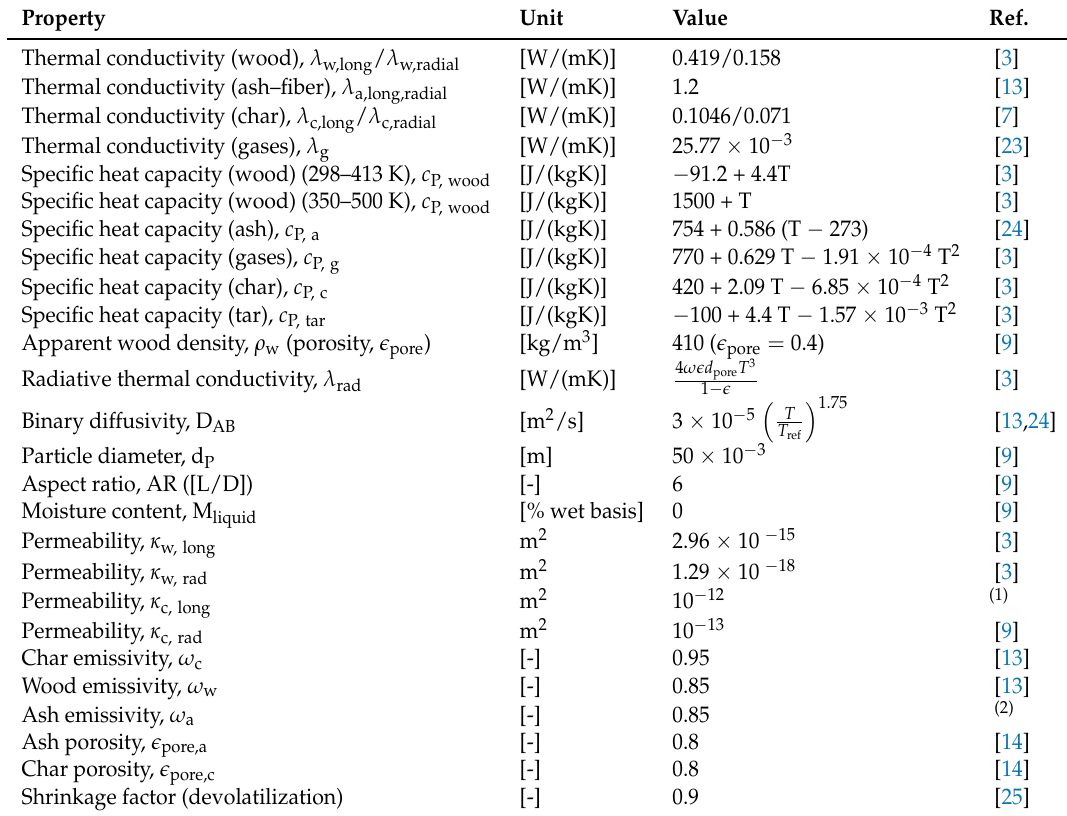
Table 2. Properties used as input values for the devolatilization